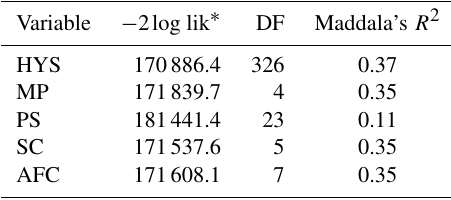
Table 2. Test statistics for the likelihood ratio